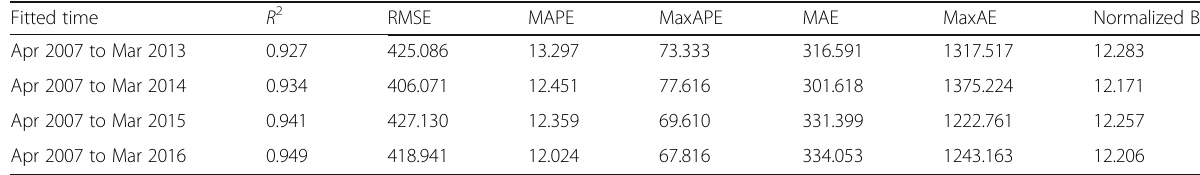
Table 1 Sensitivity of the additive model Fitted time